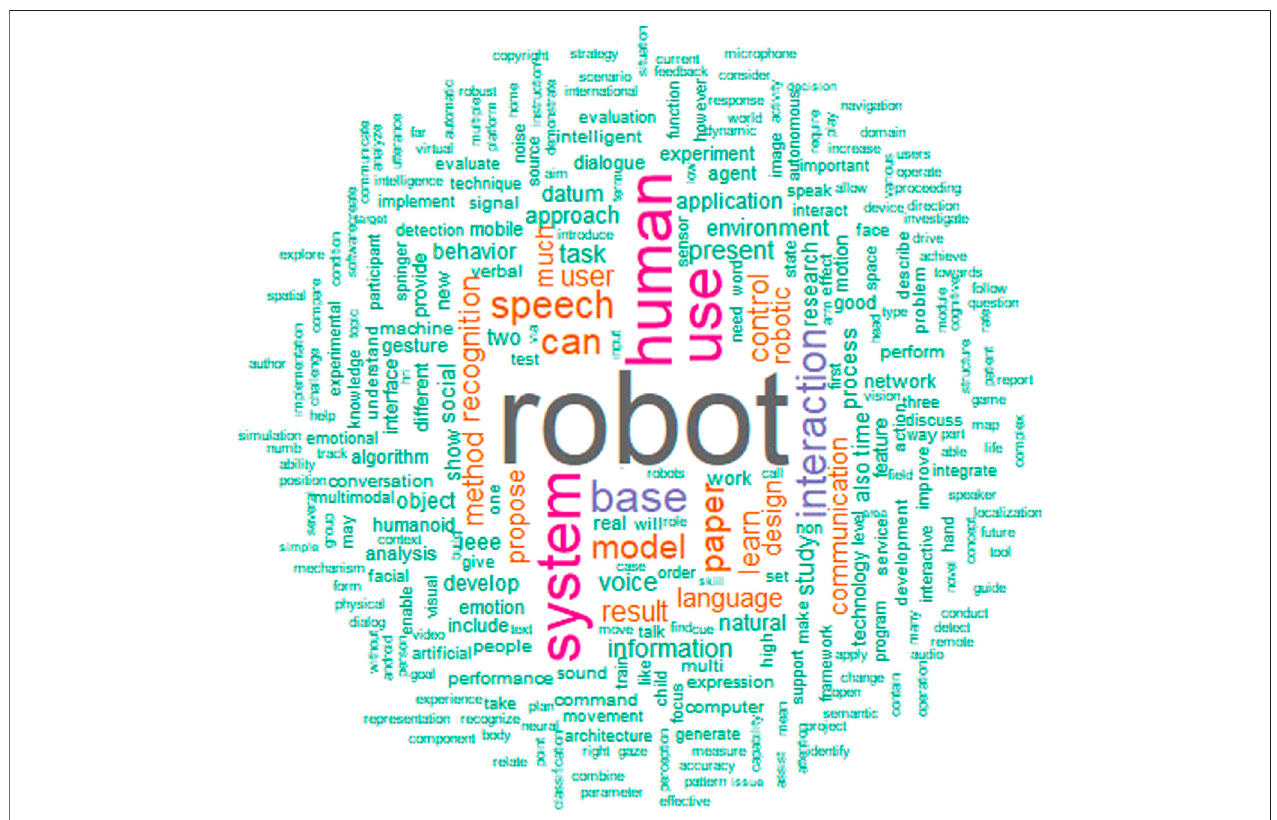
FIGURE 3 | Wordcloud of most frequent words for the non- fi ltered